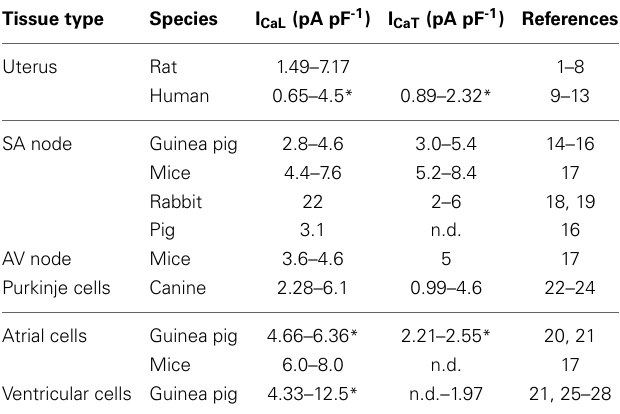
Table 1 | Summary of I CaL and I CaT current density ranges reported in uterine and cardiac cells.